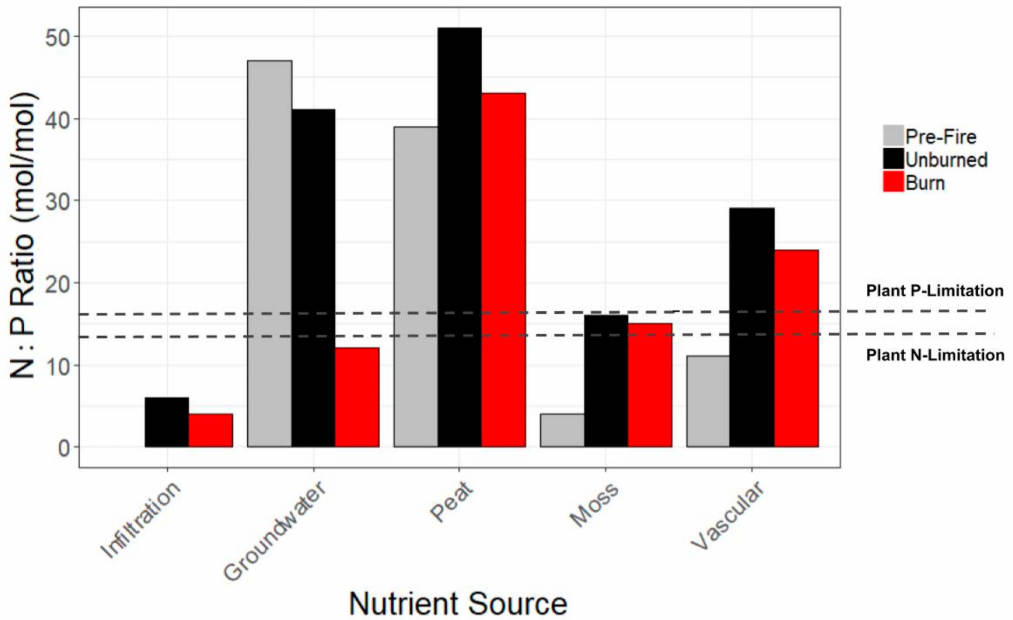
Figure 5. N:P ratios comparing pre-fire data from Nwaishi et al. [36] in the same location. Pre-fire (grey), Unburned (red), and Burned (black) areas are shown for potential sources of imbalance (groundwater, surface infiltration, and peat), as well as moss and vascular vegetation, illustrating the shifting nutrient limitations after wildfire